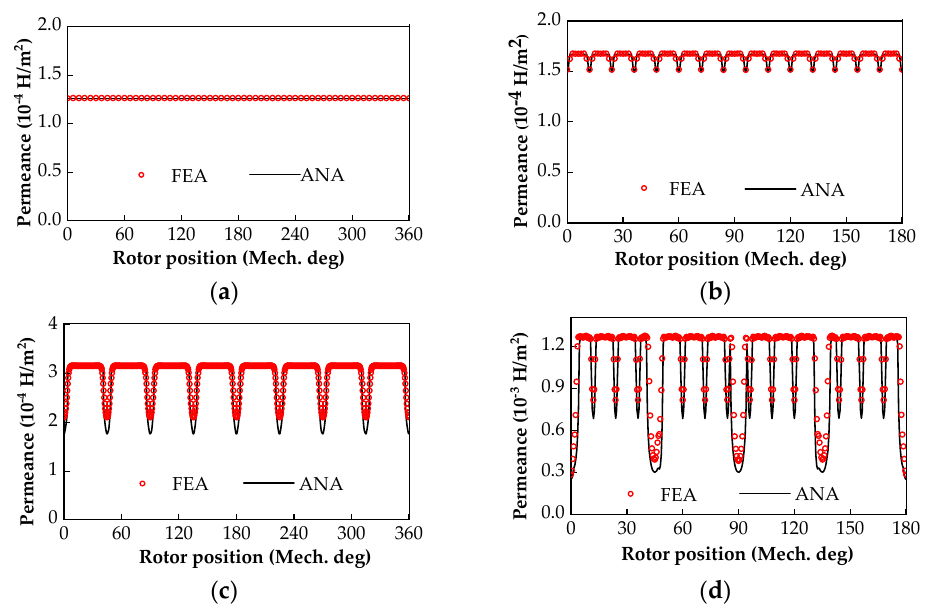
Figure 5. Air-gap permeance distribution of the four typical PMECCs: ( a ) Model − A; ( b ) Model − B; ( c ) Model − C; ( d ) Model − D.